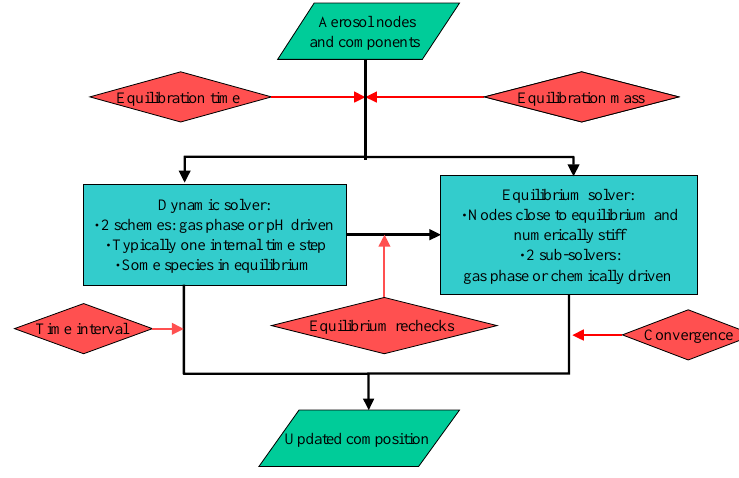
Figure 2. Formalism of HyDiS-1.0 in its hybrid configuration.